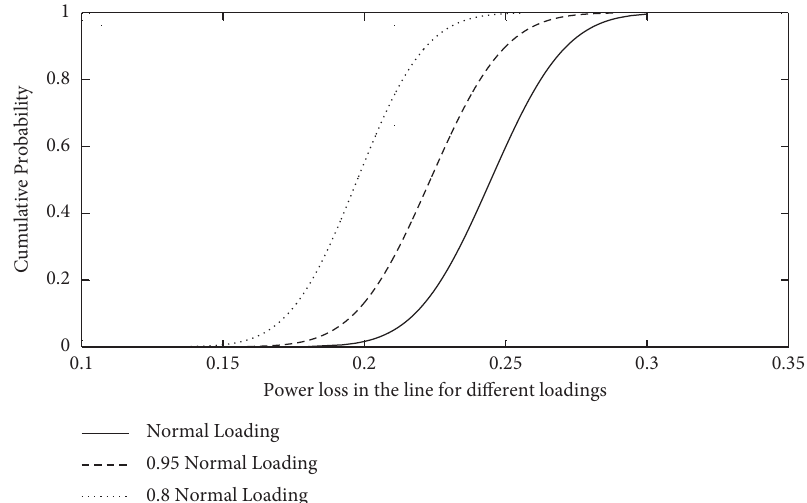
Figure 7: Distribution function of power loss in the line connecting the bus nos. 2 and